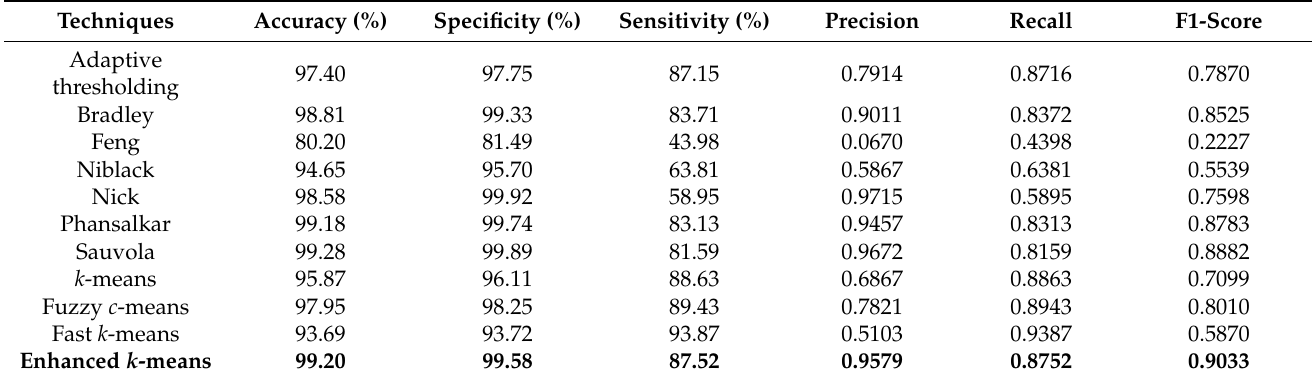
Table 5. Average segmentation evaluation consisting of accuracy, specificity, sensitivity precision, recall, and F1-score of 100 thin blood smear images.